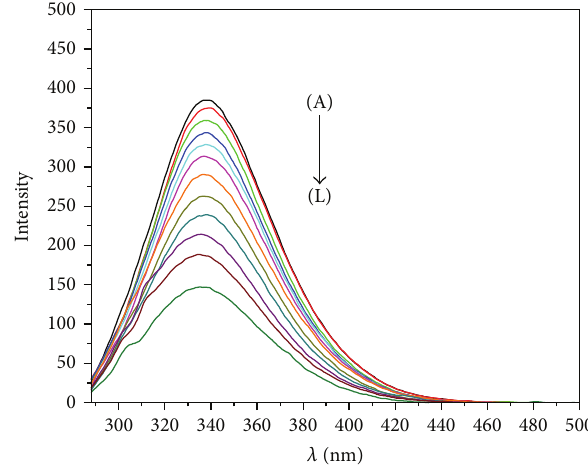
Figure 2: Fluorescence spectra of BSA (50 𝜇 g ⋅ mL −1 ) in the absence (A) and in presence of EVG at different concentrations. EVG concentrations were 0.1 𝜇 g ⋅ mL −1 (B), 0.3 𝜇 g ⋅ mL −1 (C), 0.5 𝜇 g ⋅ mL −1 (D), 0.7 𝜇 g ⋅ mL −1 (E), 1.0 𝜇 g ⋅ mL −1 (F), 3.0 𝜇 g ⋅ mL −1 (G), 5 𝜇 g ⋅ mL